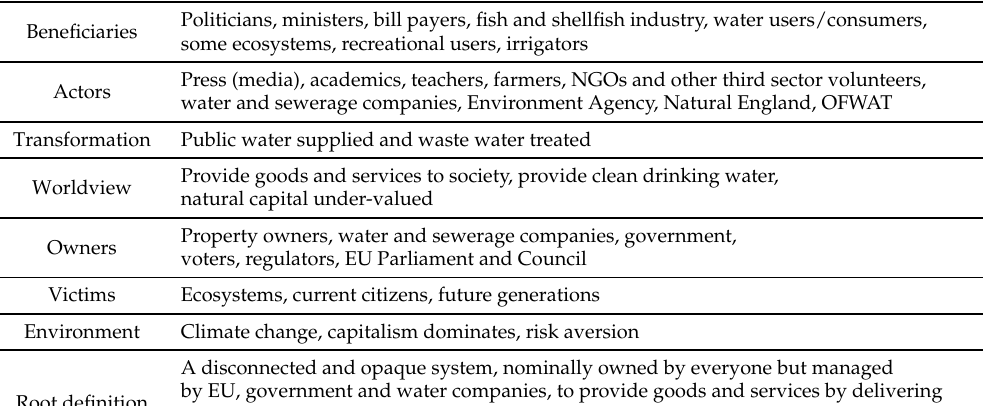
Table 2. BATWOVE (beneficiaries, actors, transformation, world-view, owners, victims and environmental constraints) and root definition applied to the water governance situation by a group of workshop participants (redrawn from the version created at the workshop; see also Table S2)